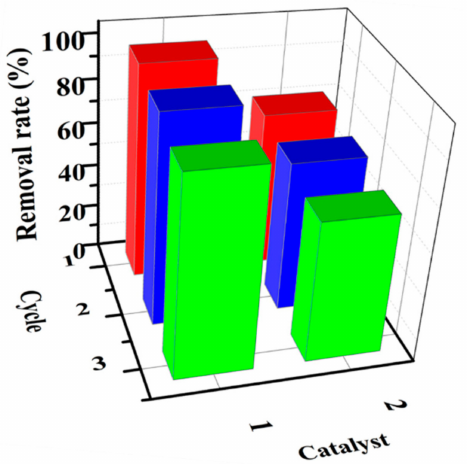
Figure 9. The effect diagram of the TC/catalysts 1 and 2 system for three cycles.